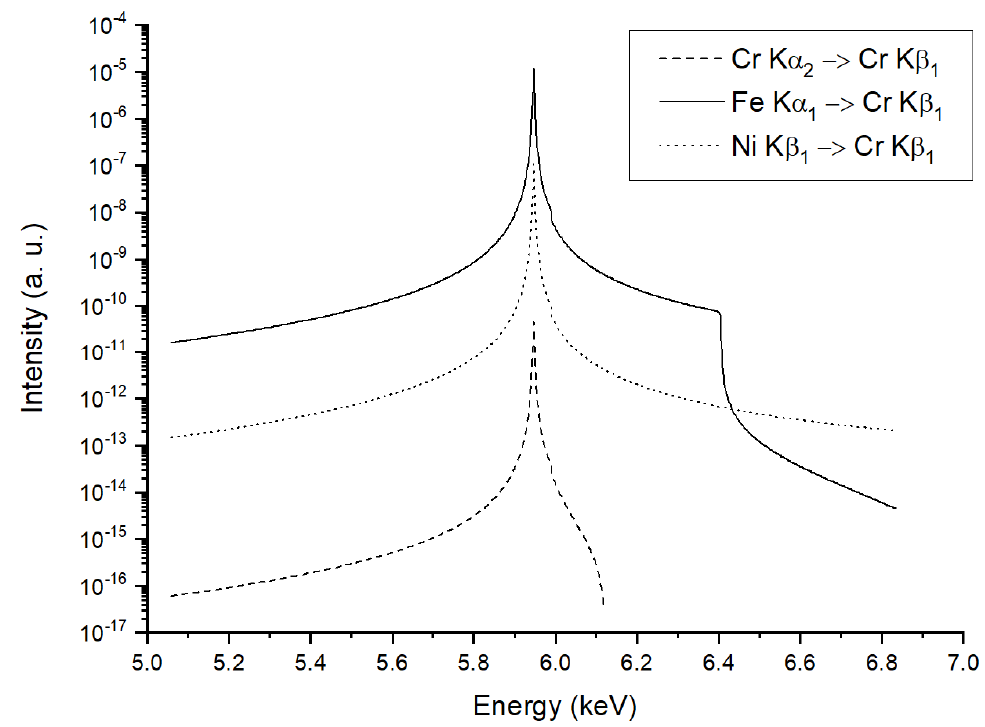
Figure 7. Second-order XRF enhancement terms to the Cr Kb1 line of a ternary sample Cr-Fe-Ni showing different asymmetries. Multiple scattering of characteristic Lorentzian lines may affect the shape of the line and its symmetry.